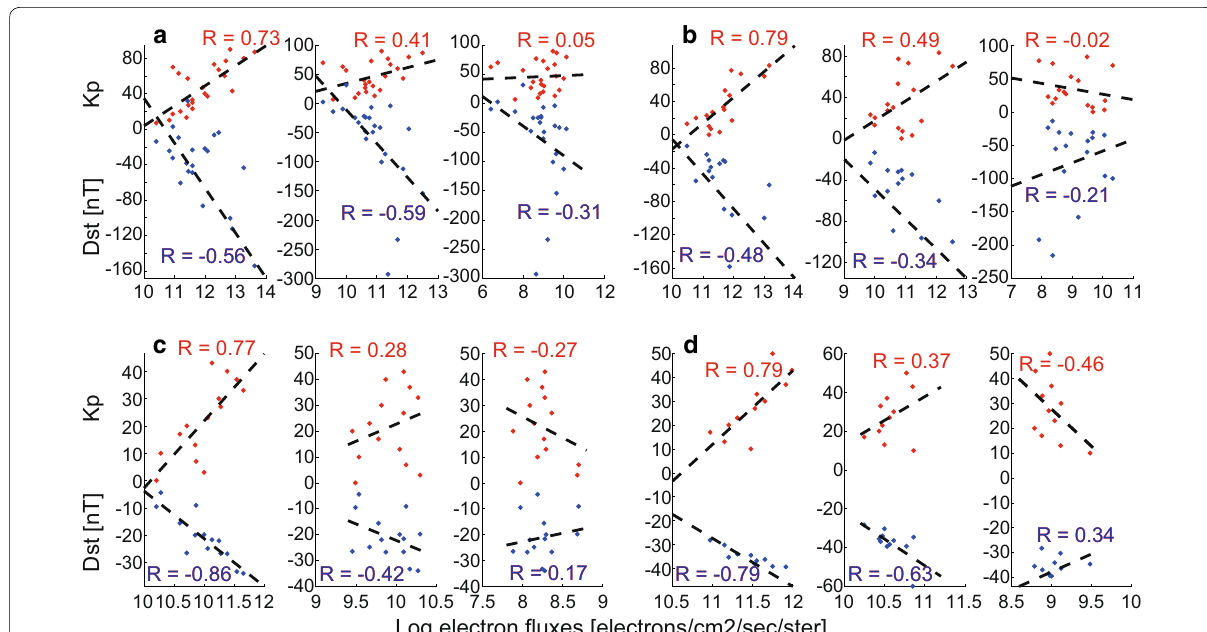
Fig. 2 Relationship of geomagnetic variability (Kp and Dst indices) and electron fluxes for channels E1 (left), E2 (middle), and E3 (right) around the day of anomaly for a ASCA, b FUSE (1), c ERS-1, and d Radarsat-1(1). The red and blue spots indicate the relationship with Kp and Dst data, respec-